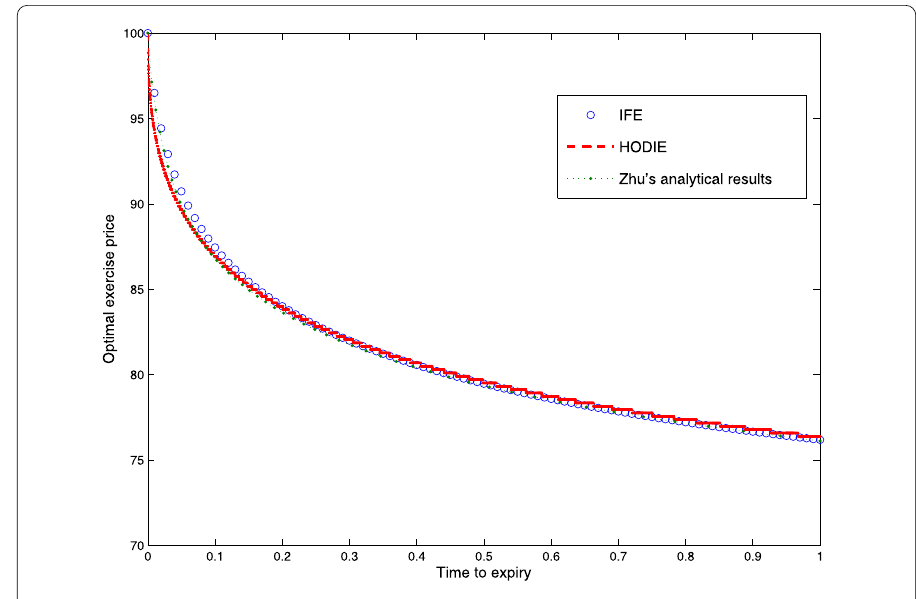
Figure 3 Comparison of the optimal exercise price. Model parameters are σ = 0.3, r = 0.1, D = 0, T – t = 1(year), E = $100, X = 400